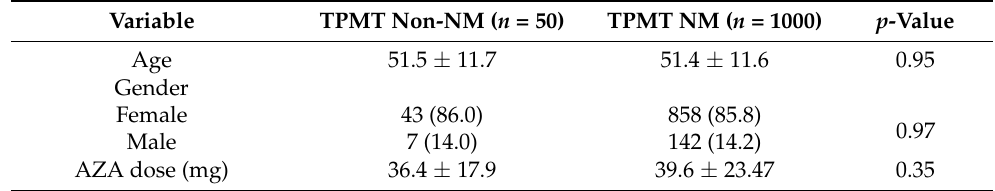
Table 1. Clinical and demographic characteristics of patients in the TPMP non-NM and NM groups. Variable